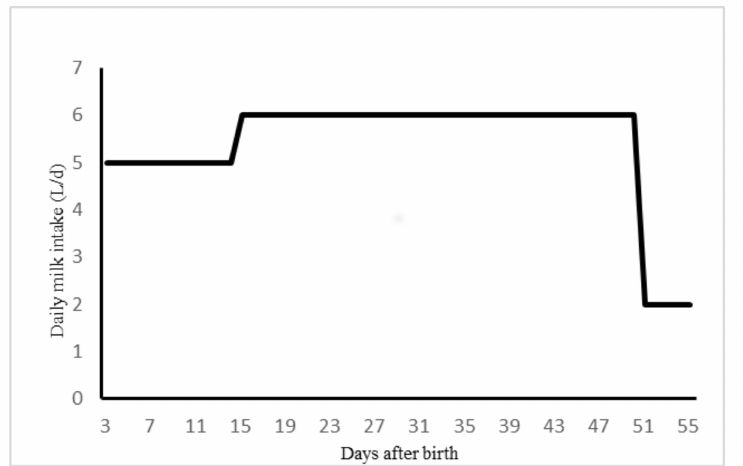
Figure 1. Milk feeding method for calves (5 L of milk/d from 3 to 14 d, 6 L/d from 15 to 50 d, and 2 L/d from 51 to 55 d of age).